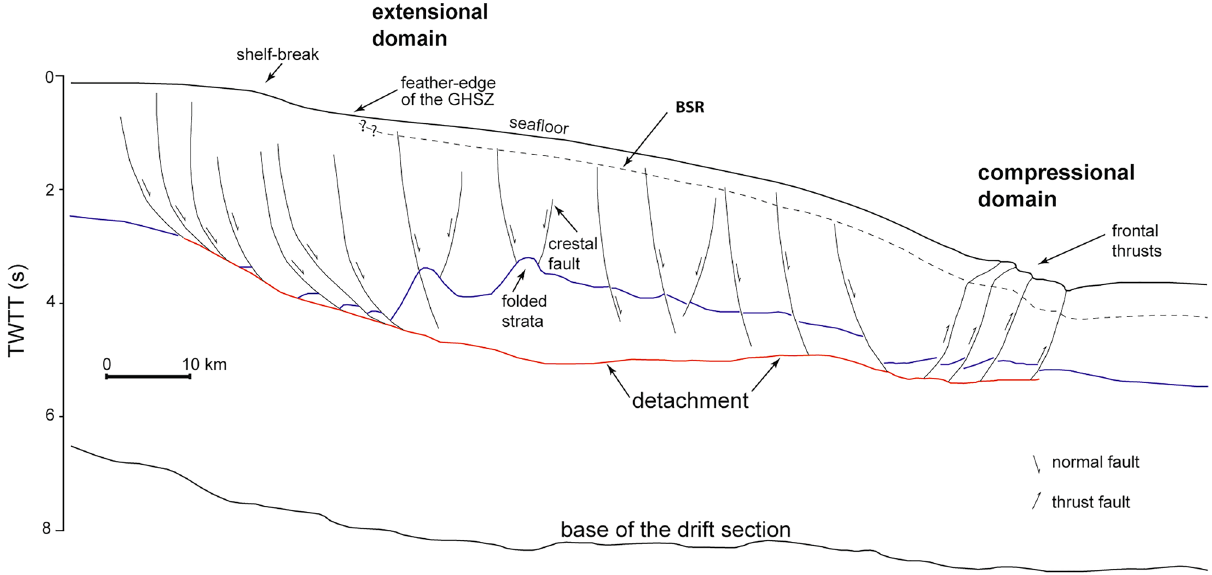
Figure 2. Line drawing showing the main structural framework of the Rio Grande Cone (RGC), the bottom simulating reflector (BSR) and the location of the feather-edge of the gas hydrate stability zone (GHSZ). The base of the drift section of the South Atlantic in the RGC is Albian/Cenomanian in age 39 , while the detachment (in red) cuts Lower Miocene shales at the centre of the figure (ca. 5 s). The blue line represents the top of Middle-Upper Miocene deposits. Line drawings were obtained from an interpreted seismic profile of a previous work in the area 40 (line 0228–0312). See Fig. 1 for